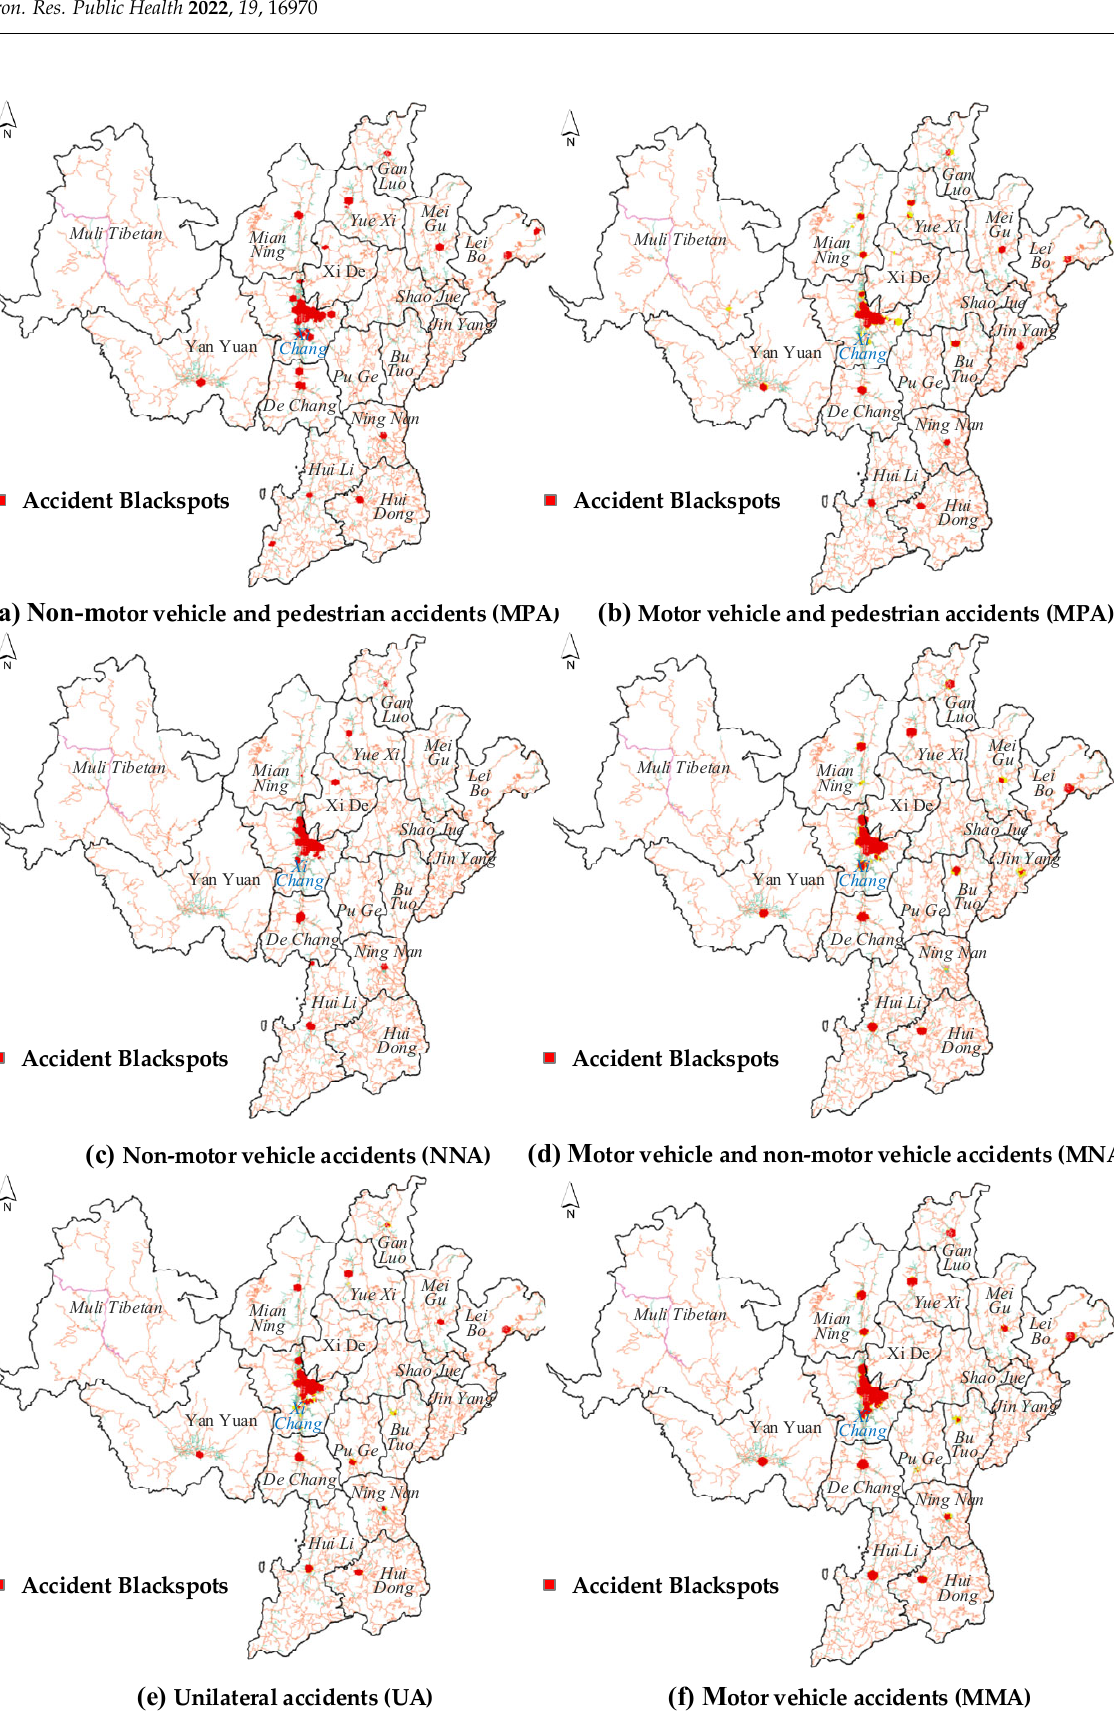
Figure 4. OHSA identification results for classifications by accident participants.